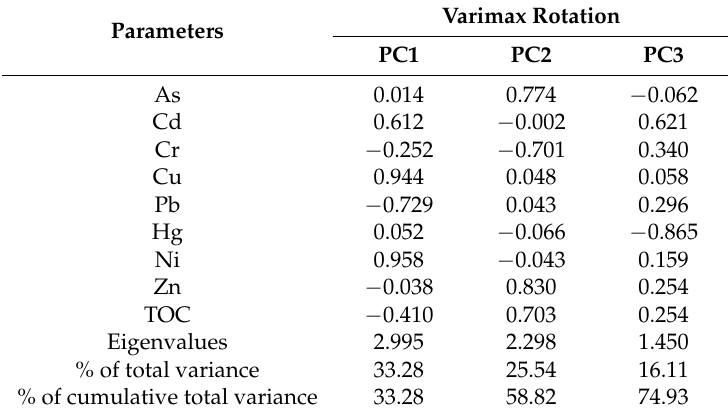
Table 5. Total variance and component matrices for the heavy metals in the surface sediment from the Awash River